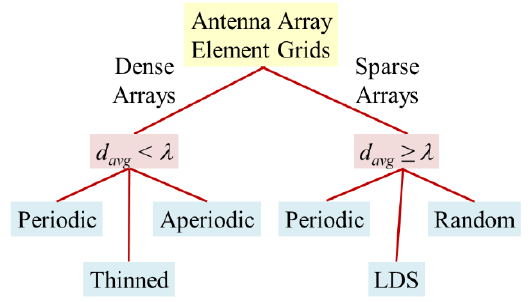
Figure 1. Categories of antenna array grids.